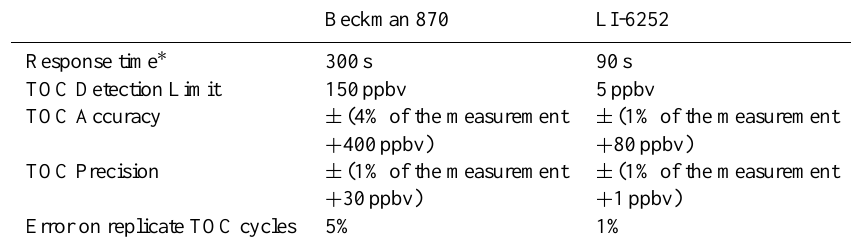
Table 2. Performance of MOCCS with the Beckman Industrial Model 870 NDIR and the LI-COR LI-6252.